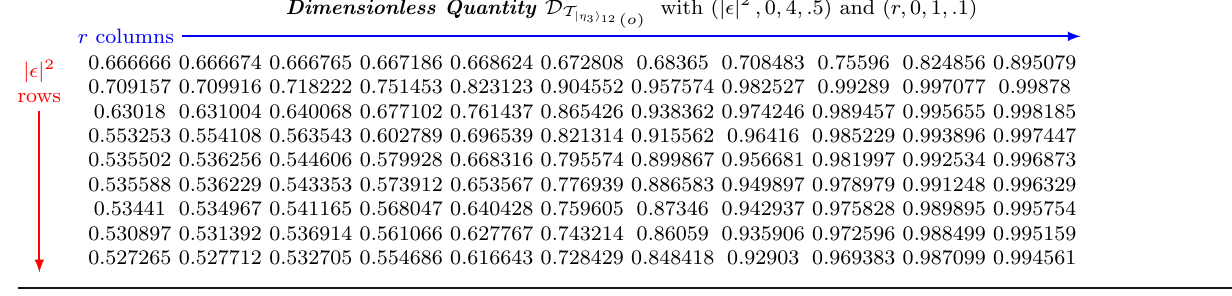
Table 11 Numerical values of D T for some range and choices of coherent and squeezing parameters. Here, | (cid:11) | 2 takes on value from 0 to 4 and r varies from 0 to 1